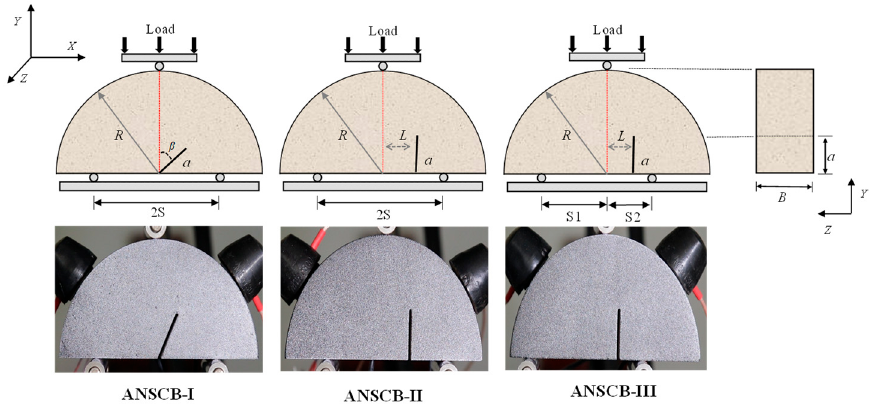
Figure 1. Diagrams and photos of three different asymmetric notched semi-circular bending speci- mens. The circles on the top and bottom of the specimen represent the loading and supporting rollers, respectively. it should be noted that the white-black speckle on the sample surface can be analyzed by the DIC